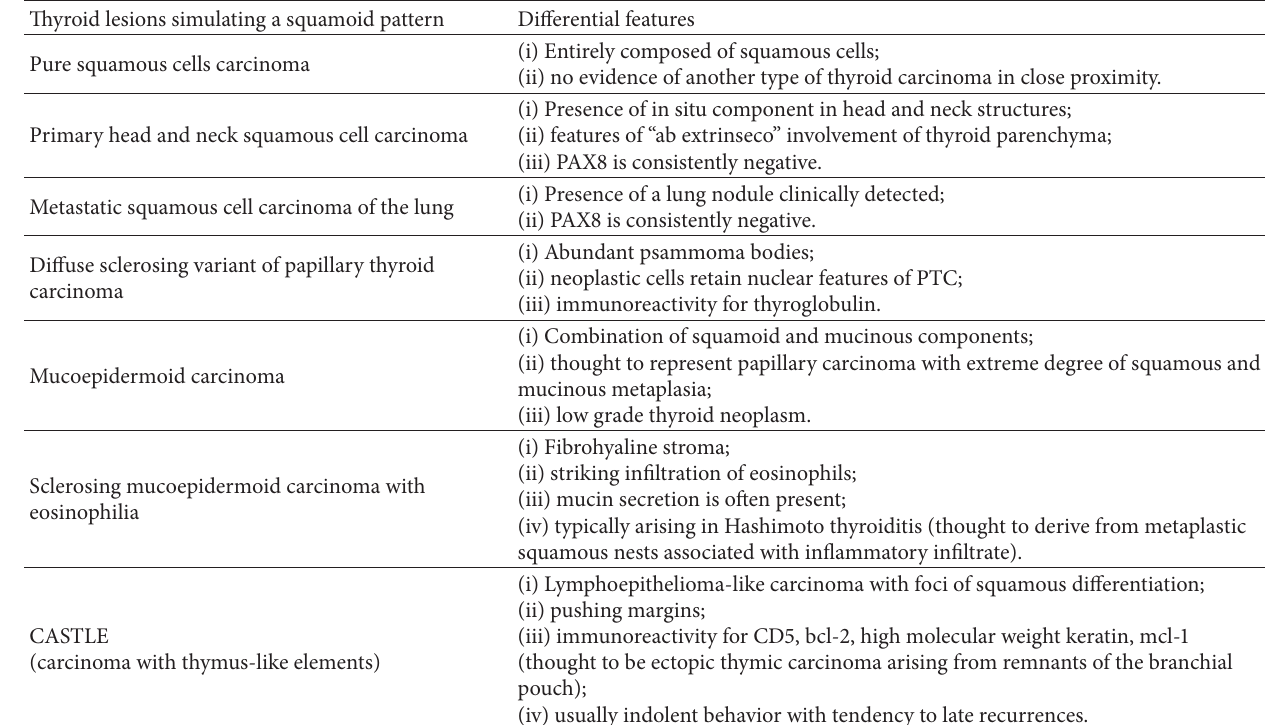
Table 2: Differential diagnoses of squamoid category.